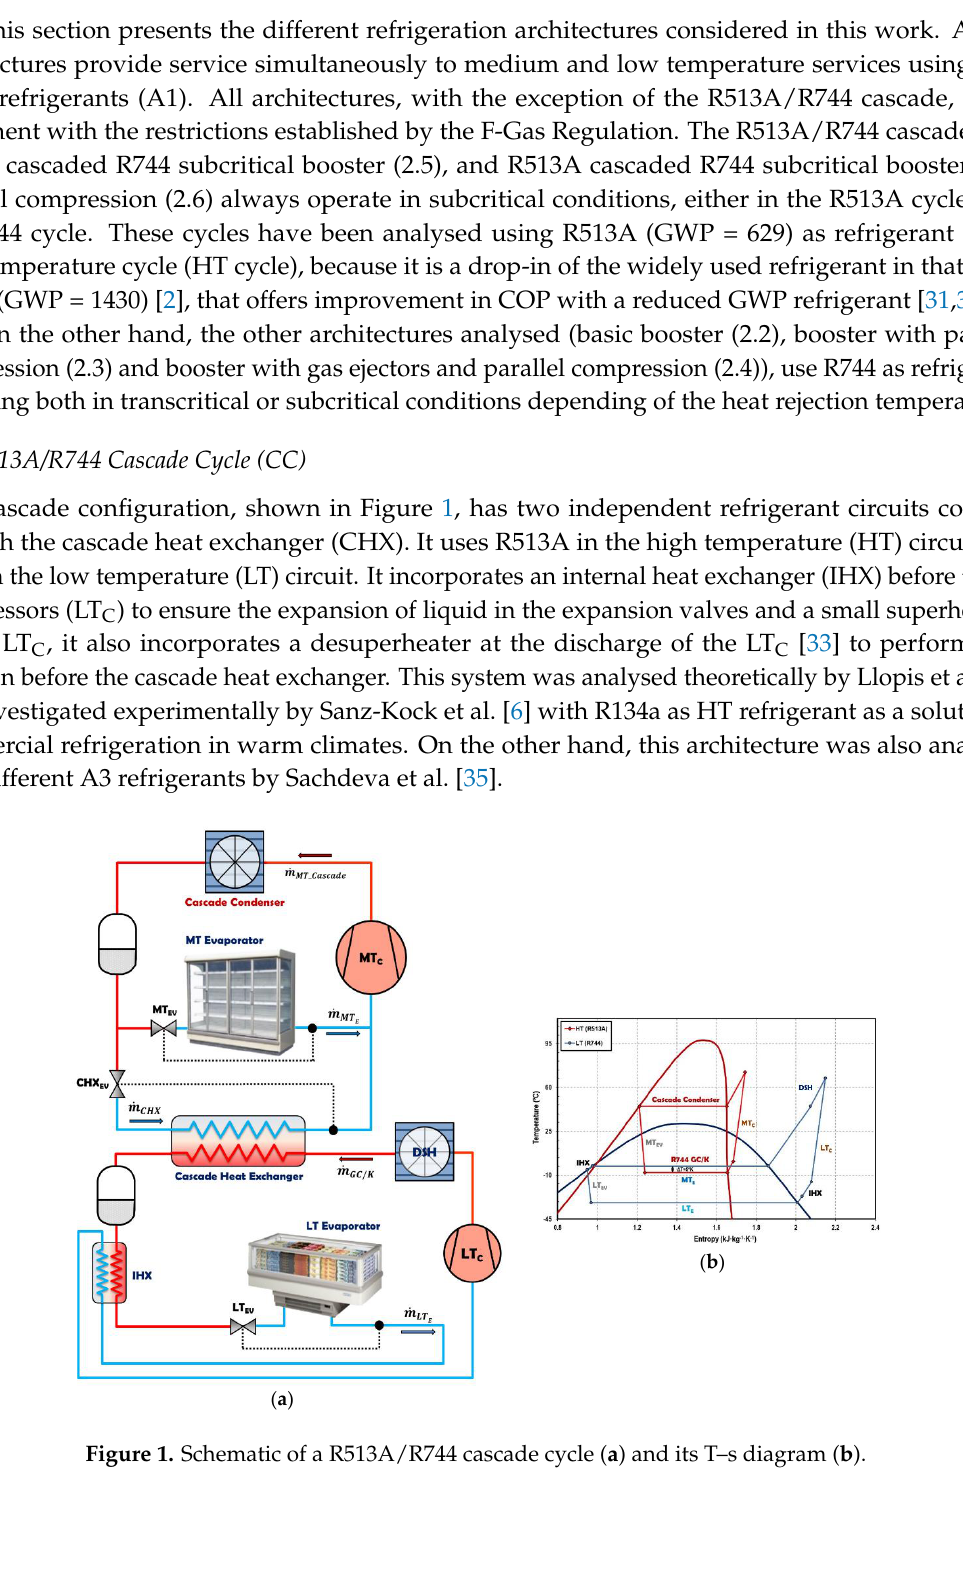
Figure 2. Schematic of a basic booster ( a ) and its p–h diagram ( b ). 2.3. Booster with Parallel Compression (BB + PC) The booster with parallel compression configuration, Figure 3, uses the same architecture as the basic booster (BB) but it includes additional compressors denoted as parallel compressors (PC). The PC extracts saturated vapour from the flash tank and it is compressed to the high rejection pressure. As analysed theoretically by Sarkar et al. [39] in a simple stage, the use of PC allows one to reduce the pressure in the flash tank and to increase the specific cooling capacity. In addition, these compressors reduce the mass flow rate in MT and LT services and in the LT C and MT C . Chesi et al.